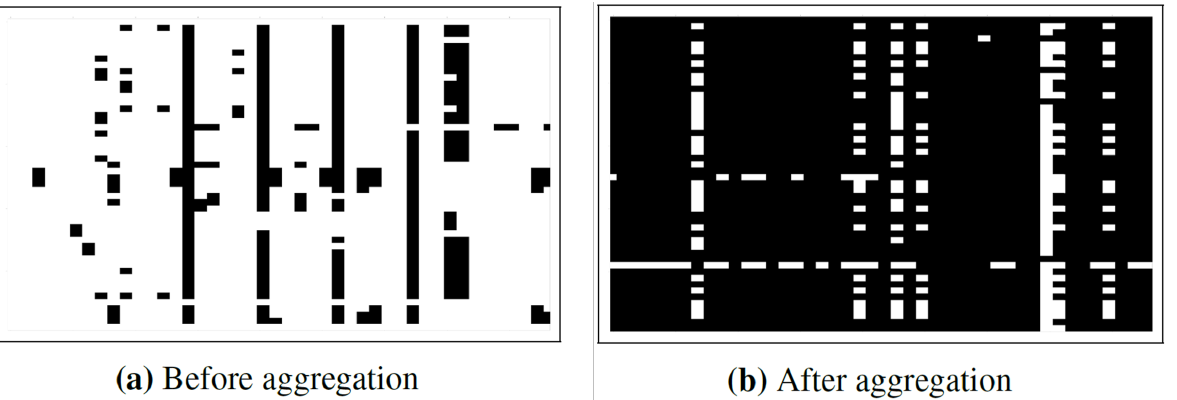
Figure 8. Qualitative depiction of reduction in data sparsity through aggregation and feature extrac- tion. White spaces indicate empty cells.